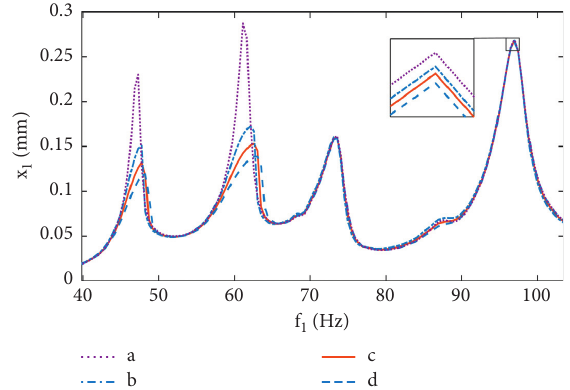
Figure 10: Amplitude-frequency curves when rear low-pressure SFD is implemented (a: no SFD, b: 0.25mm, c: 0.20mm, d: 0.15mm).